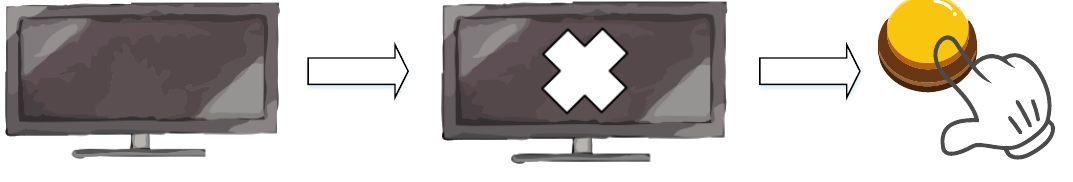
Figure 2. Alert stimuli response process in TAV.